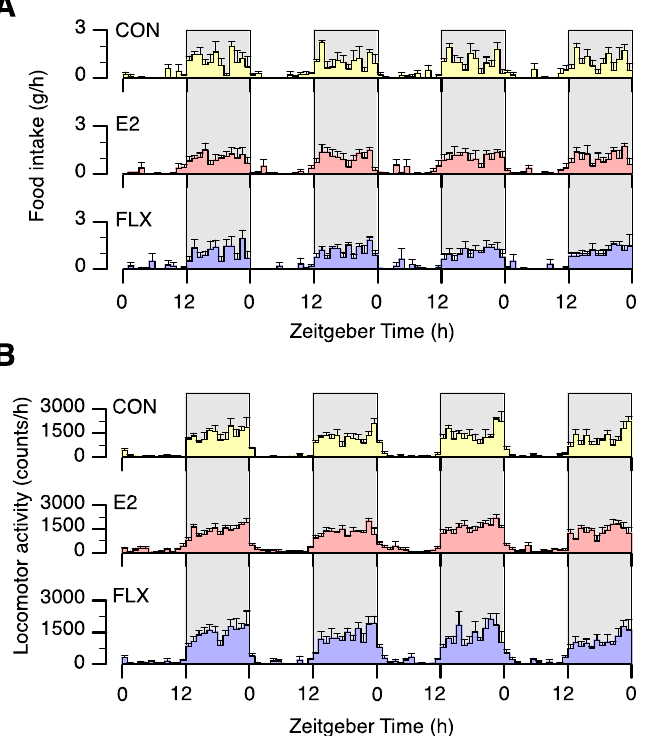
Figure 2. The effect of estradiol (E2) replacement or fluoxetine (FLX) administration on circadian feeding (A) and locomotor activity (B) patterns for 4 days. Female rats were ovariectomized and assigned to the estradiol- or cholesterol-treated group. Six or seven days after the ovariectomy, a half of the cholesterol-treated rats were subcutaneously ( s.c. ) injected with 5 mg/kg fluoxetine (FLX) twice a day at ZT 0 and 12 every day, while the other half of the cholesterol-treated rats (CON) and all of the estradiol-treated rats (E2) were s.c. injected with the same volume of saline. Mean food intake over the 4 days during the light phase was lower in the FLX and E2 groups than in the CON group but similar in the FLX and E2 groups (Figure 3A). During the dark phase, however, there were no differences in food intake among treatment groups (Figure 3B). Daily food intake was significantly lower in the E2 group than the CON group and tended to be lower ( p = 0.08) in the FLX group than in the CON group (Figure 3C) Figure 3. The effect of estradiol (E2) replacement or fluoxetine (FLX) administration on food intake during the light phase (A) and dark phase (B) , and daily food intake (C) in ovariectomized female